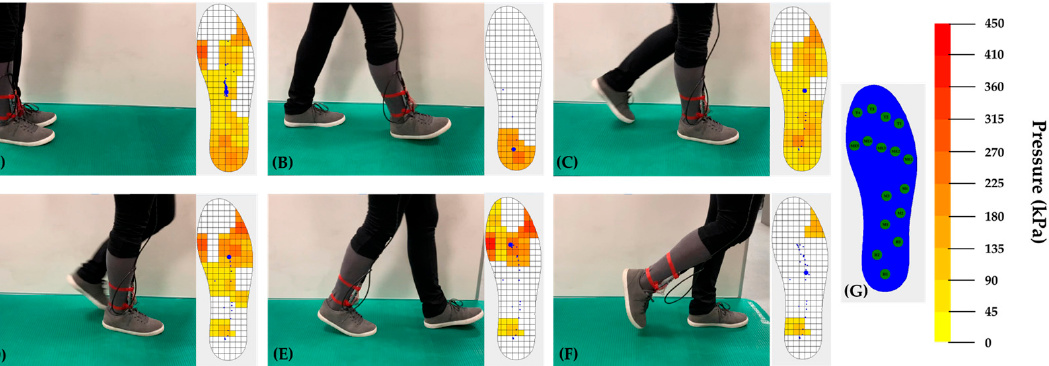
Figure 12. Plantar pressure distribution (heatmap) of the right foot under the main phases of a normal gait cycle: ( A ) stance, ( B ) heel strike, ( C ) foot flat, ( D ) midstance, ( E ) heel off and ( F ) toe off, ( G ) insole sensors arrangement and color map of the pressure range.